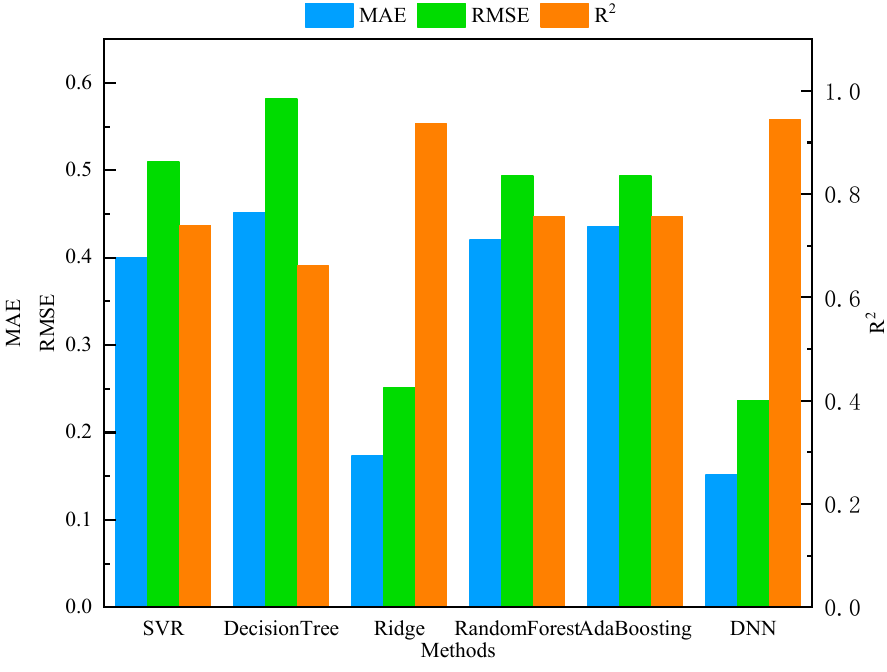
Figure 10. Prediction performance of the DNN model and other models.